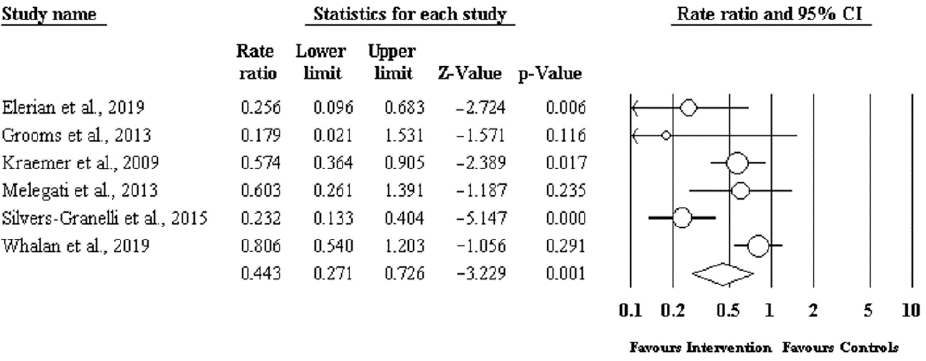
Figure 2. The forest plot visually depicts the effectiveness of the interventions. The preventive interventions proposed by the different articles analysed were effective in preventing HSIs with statistical significance ( p = 0.001) among professional and semi-professional football players.